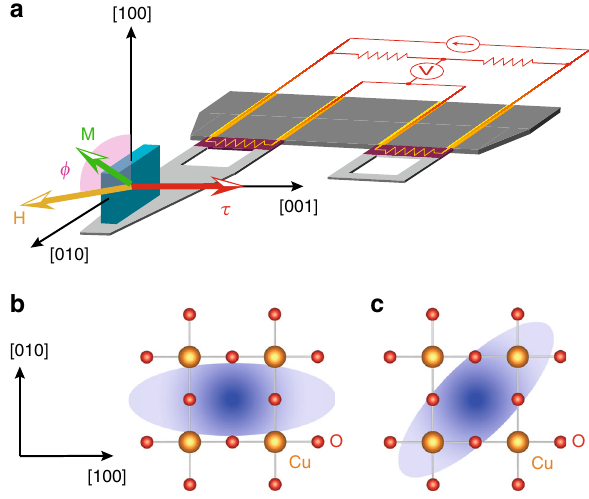
Fig. 2 Torque magnetometry determination of nematic order. a The experimental con fi guration for in-plane torque magnetometry, by which magnetic torque τ = μ 0 V M × H is mesasured. Yellow, green and red arrows indicate the directions of H , M and τ , respectively. The magnetic fi eld H is rotated within the tetragonal ab plane. A single-crystalline sample of Hg1201 is mounted on the piezoresistive lever, which forms an electrical bridge circuit with the neighbouring reference lever. b Schematic picture of bond nematicity with B 1 g symmetry, where the nematicity appears along the Cu – O – Cu direction. For this nematicity, χ aa ≠ χ bb and χ ab = 0. c Diagonal nematicity with B 2 g symmetry, where the nematic director is along the diagonal direction of CuO 2 square lattice. For this nematicity, χ aa = χ bb and χ ≠ ab